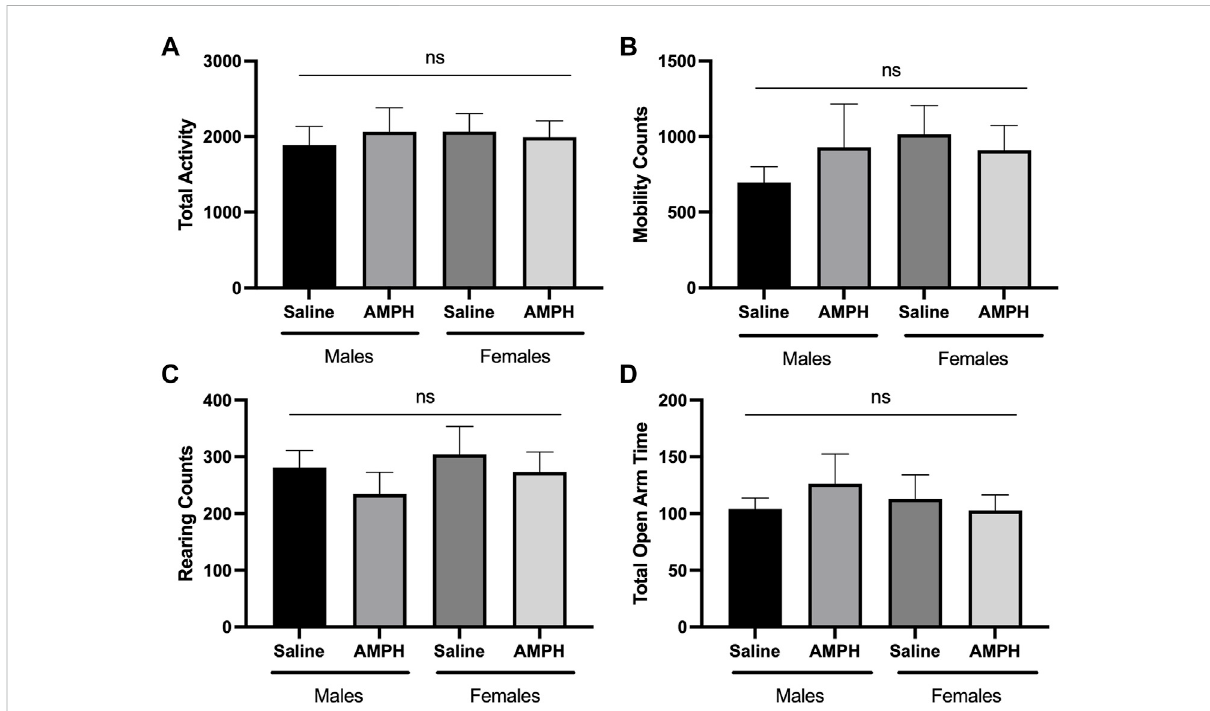
AMPH treatment had no effect on the behavioral response of male and female WT mice in the open- fi eld and elevated plus maze. (A — C) HistogramsshowthemeanandSEMof.behavioralperformancesofWTmaleandfemalemiceindifferentopen- fi eldassessmentstreatedwitheither saline or 1 mg/kg AMPH during a 30-min period. Parameters assessed were: (A) total activity, (B) mobility counts, (C) rearing counts. (D) Histogram showingthemeanand SEMoftheelevated plusmazetestmeasuring thetotalamountoftime micespent intheopen areasduring a5-min test period. Data are presented as the behavioral output observed in subjects that received AMPH normalized to those that received saline injection. (A — D) TherewasnostatisticaldifferenceinperformanceonanyofthemeasuredparametersbetweensalineandAMPHtreatmentsintheWTgroup, two-way ANOVA, open fi eld(male independentsubjects: saline n =8, AMPH n = 7;femaleindependentsubjects:saline n =8, AMPH n =9), elevated plus maze (male independent subjects: saline n = 8, AMPH n = 9; female independent subjects: saline n = 7, AMPH n =